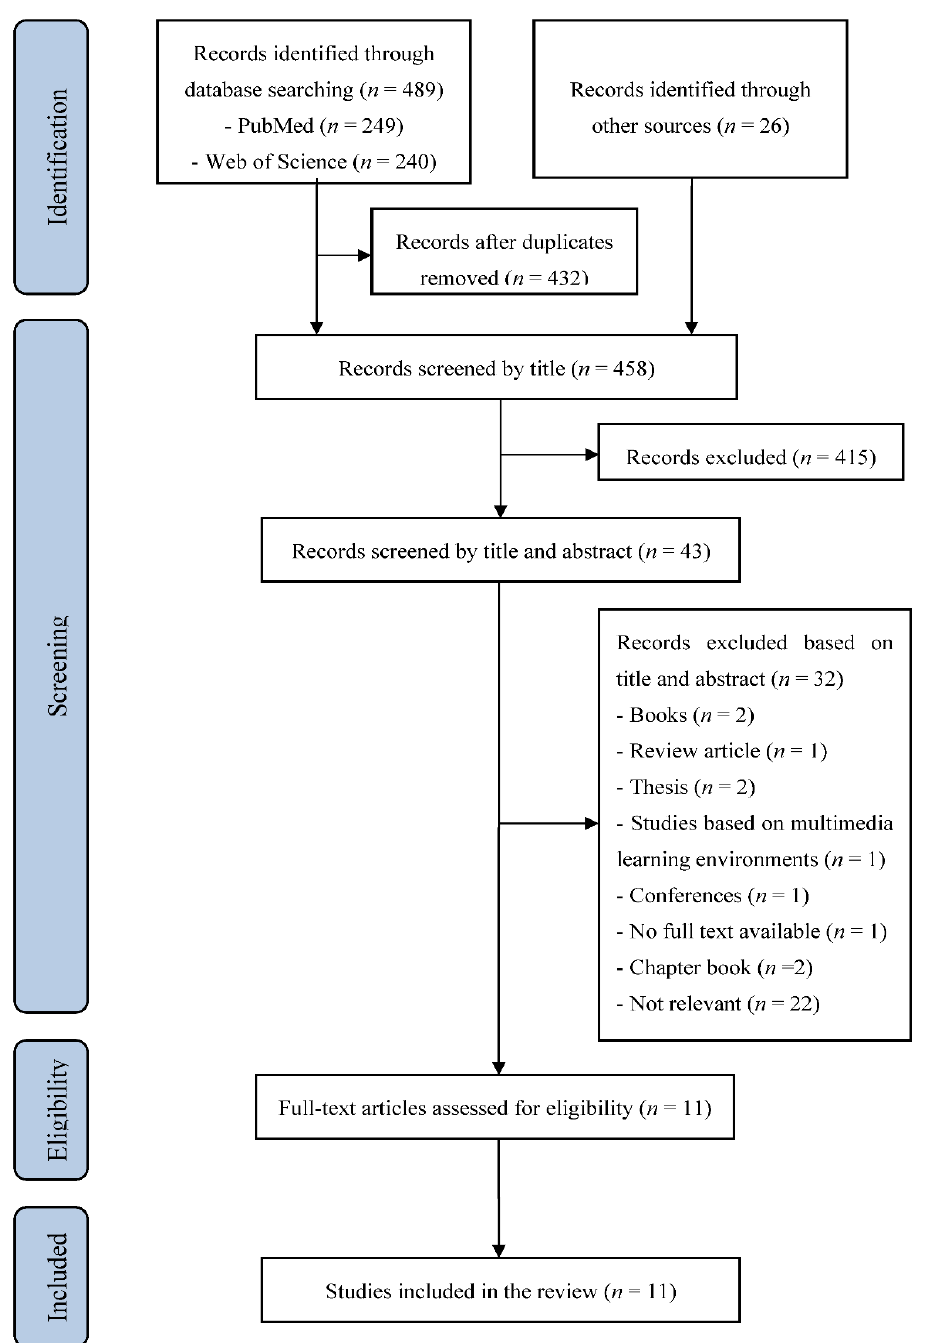
Figure 1. Flowchart illustrating the different phases of the search and study selection. A total of 11 articles fulfilled the eligibility criteria.